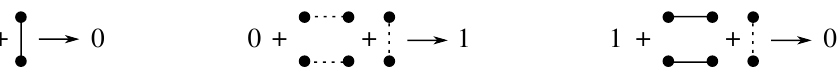
Figure 6: Fusion rules to construct left and right environments.